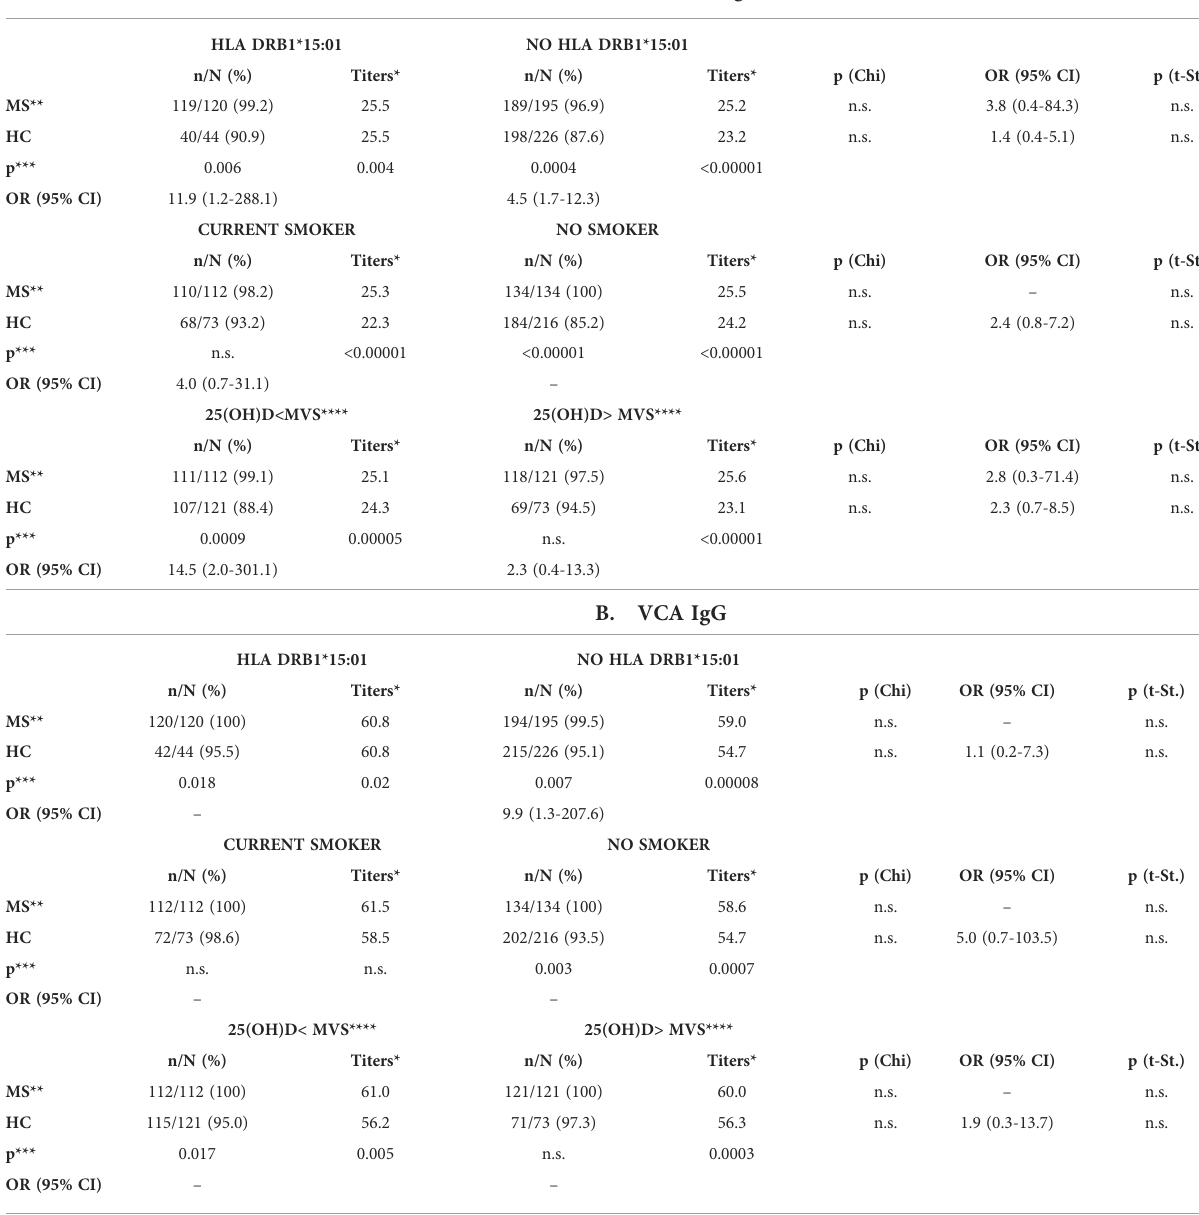
TABLE 2 Comparisons of EBNA-1 and VCA IgG titers and prevalence between untreated MS patients and healthy controls after strati fi cation according to HLA DRB1*15:01 allele, smoking habit and levels of vitamin D. A. EBNA-1